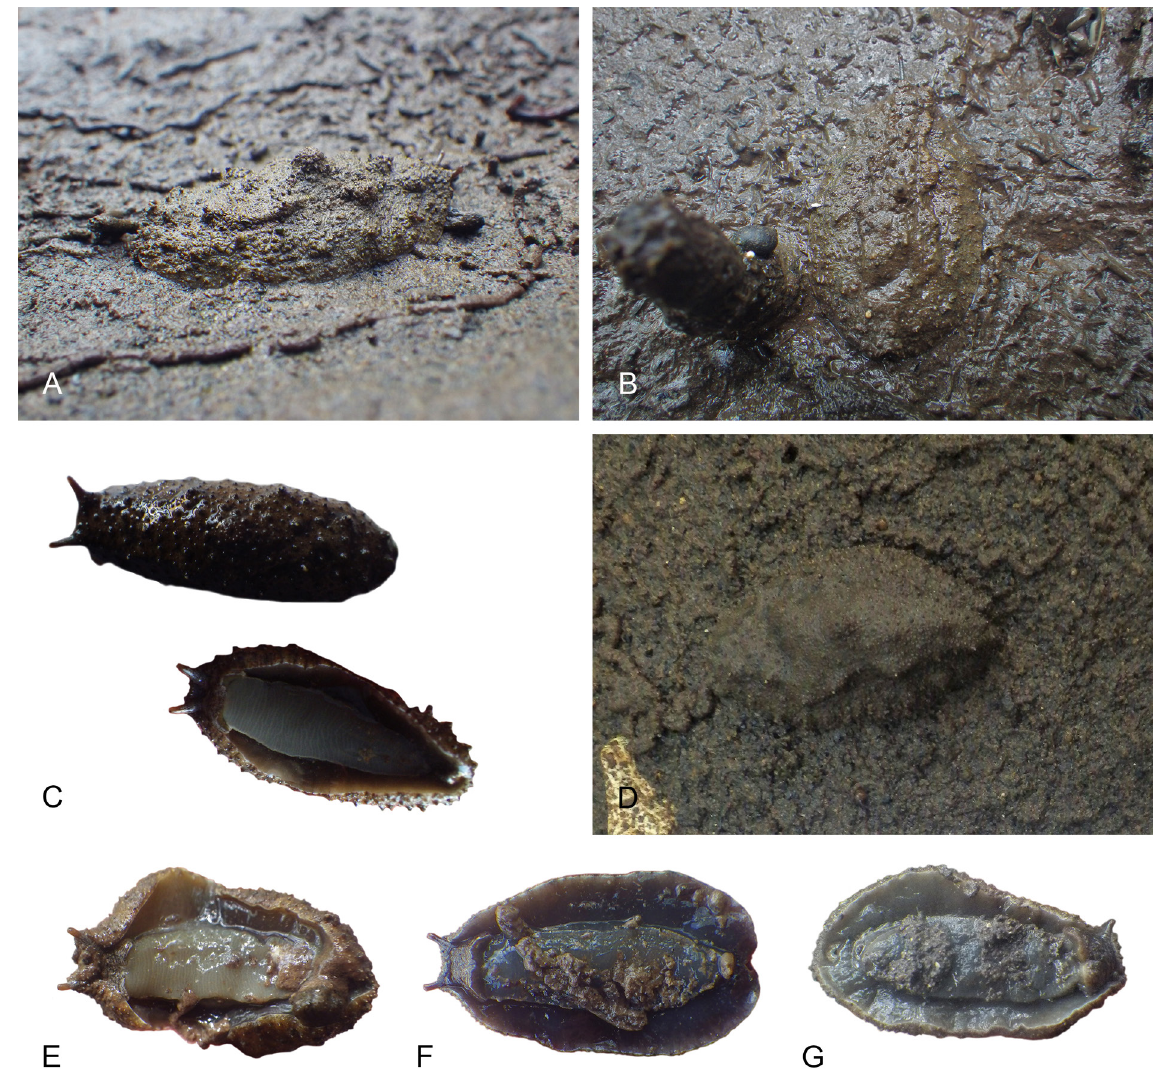
Fig. 46. Paromoionchis goslineri gen. et sp. nov. unit #2, live animals. A . Dorsal view, 33 mm long [3120], Indonesia, Bali (UMIZ 00156). B . Dorsal view, 32 mm long [5073], Indonesia, Halmahera (UMIZ 00158). C . Dorsal and ventral views, 18 mm long [2241], Indonesia, Sulawesi (UMIZ 00153). D . Dorsal view, 24 mm long [3079], Indonesia, Bali (UMIZ 00155). E . Ventral view, 26 mm long [5072], Indonesia, Halmahera (UMIZ 00158). F . Ventral view, 16 mm long [5891], Indonesia, Timor (UMIZ 00157) G . Ventral view, 26 mm long [3066], Indonesia, Bali (UMIZ